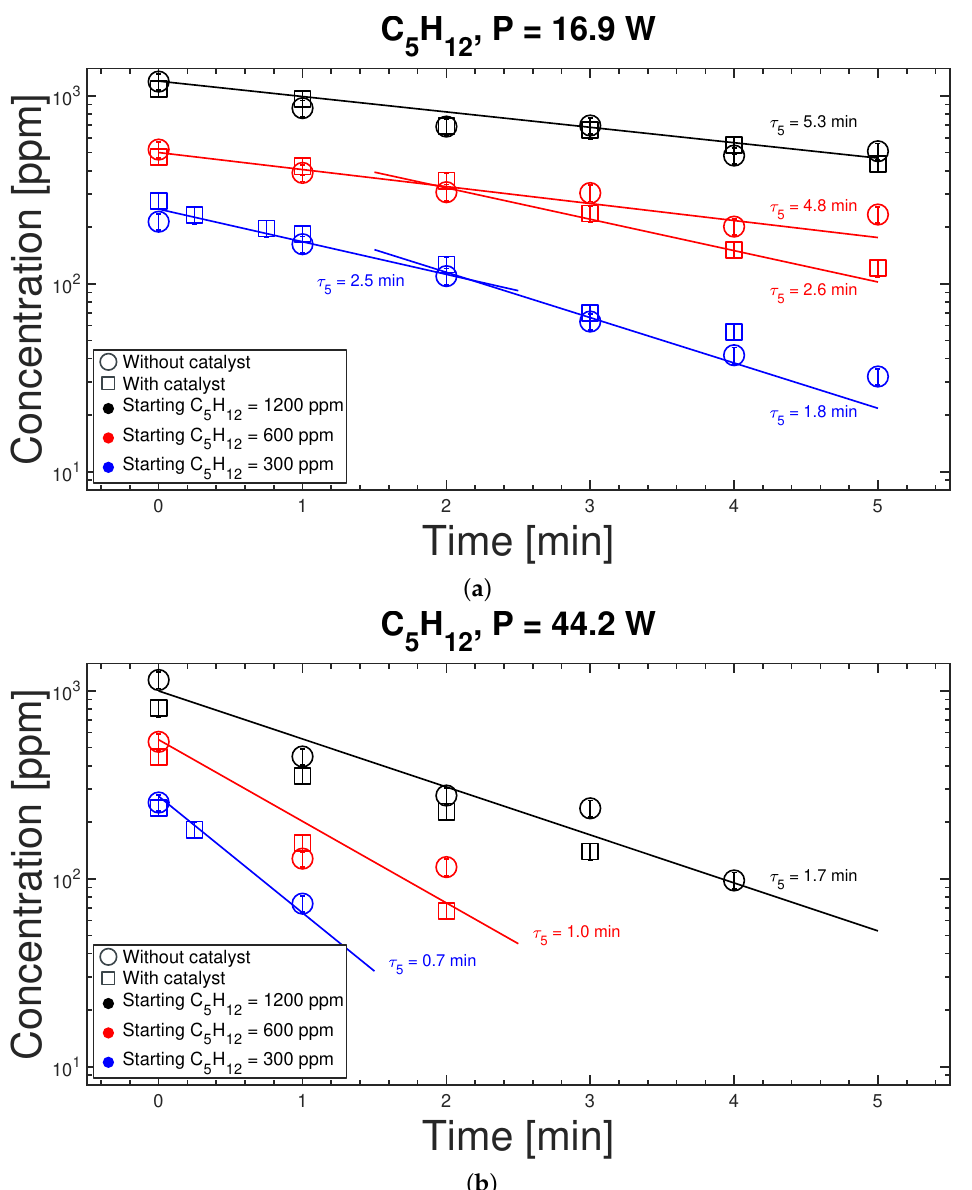
Figure 5. Depletion rate of pentane at different concentrations per plasma power: ( a ) P = 16.9W, and ( b ) P = 44.2W. The values for τ 5 (representing the slopes of the plotted straight lines) are summarized in Table1 together with the estimated errors. The latter values were obtained by taking the highest and lowest slopes consistent with the data. The experimental uncertainties in the measured values, at about 10%, are roughly the size of the symbols